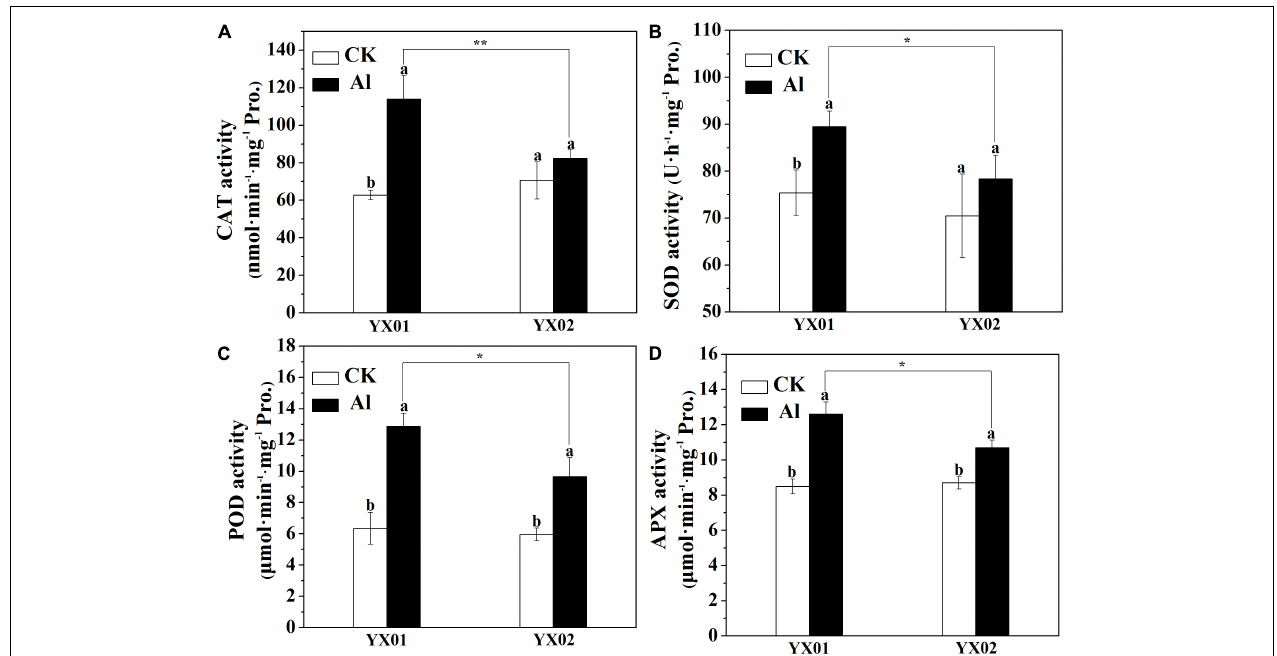
FIGURE 3 | Effects of Al treatment on the activities catalase (CAT) enzyme (A) , superoxide dismutase (SOD) enzyme (B) , peroxidase (POD) enzyme (C) , and ascorbate peroxidase (APX) enzyme (D) in roots of Chinese fir seedlings. Two-month-old Chinese fir seedlings were exposed to 1/2 strength complete nutrition solution without Al (CK), or with 1 mM AlCl 3 (Al) for 16 d. After treatment, root tips of Chinese fir were collected for analysis. Bars are means of four replicates ± SD. Different letters above histogram represent significant differences at P < 0.05 . * or ** above lines represent significant differences between genotypes at P < 0.05 and P < 0.0 1,